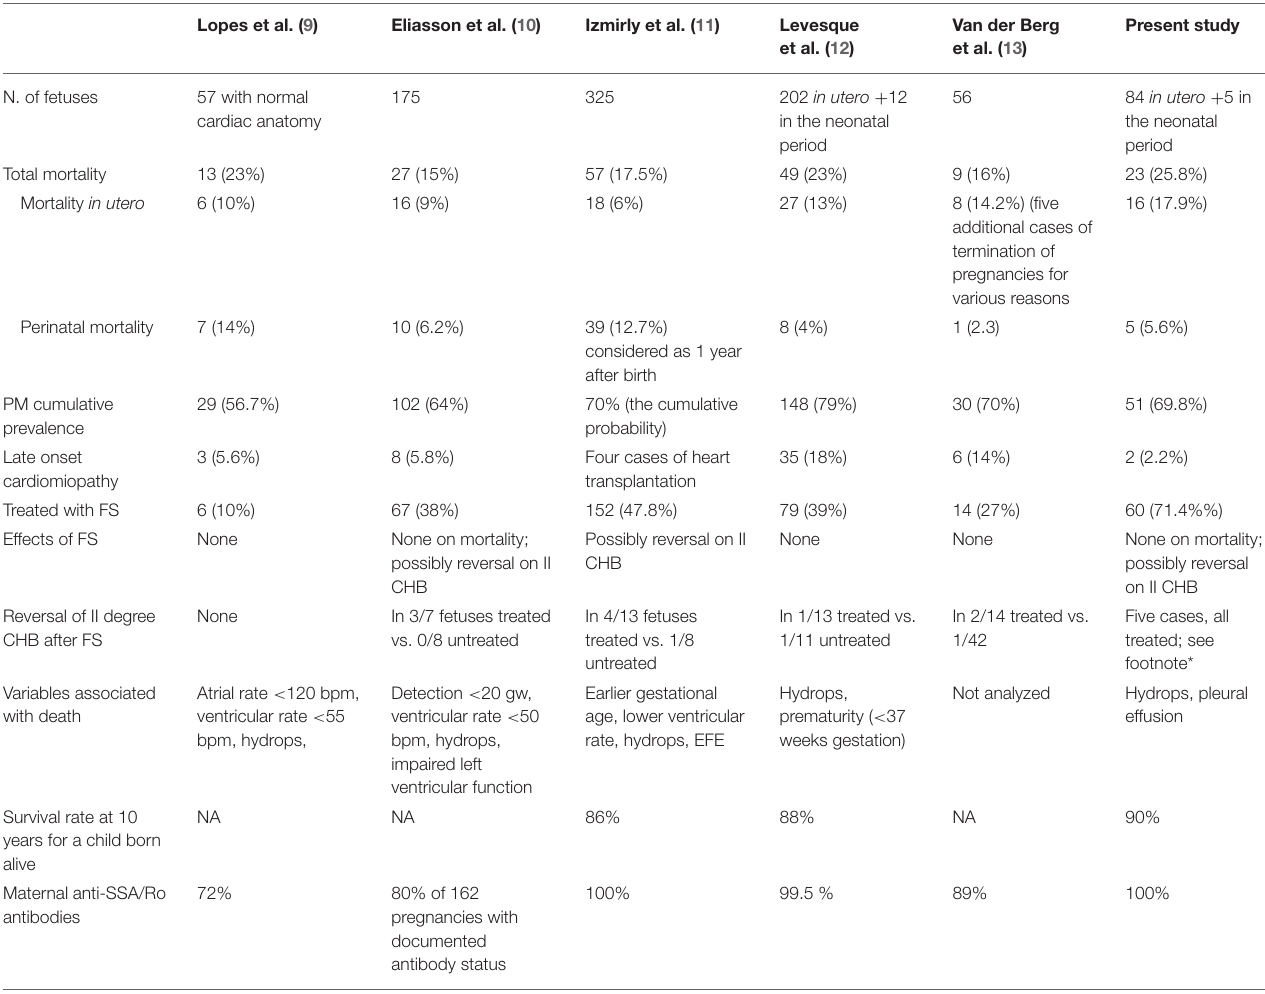
TABLE 1 | Outcome of infants with CHB in the present study and in five large international series of cases